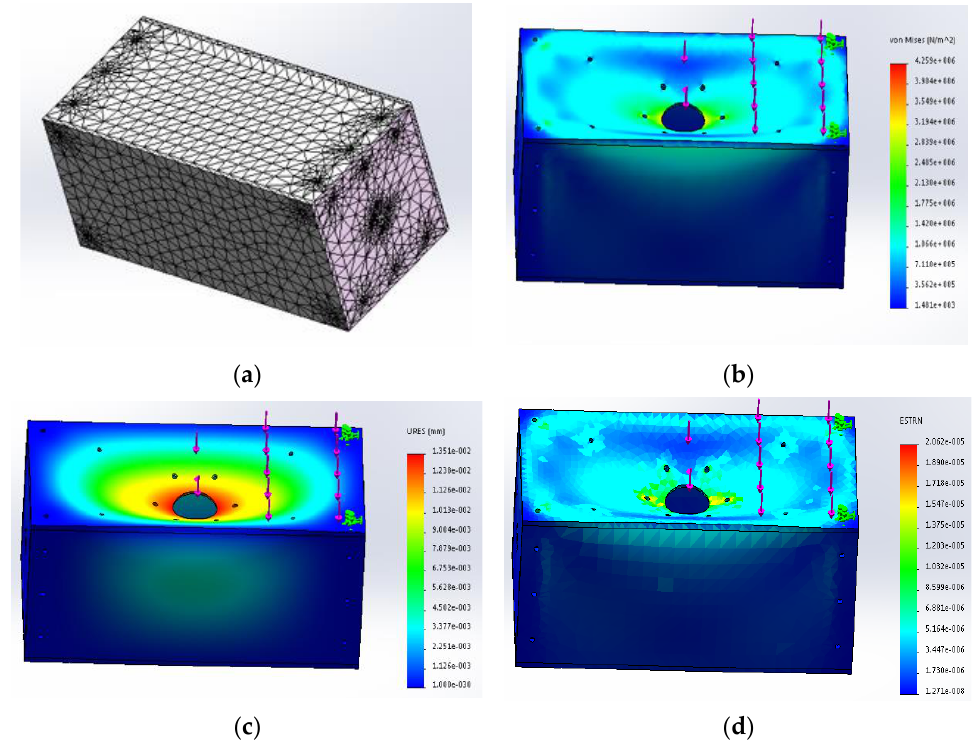
Figure 3. ( a ) Bottom structure meshing. ( b ) Equivalent stress cloud diagram of bottom structure. ( c ) Equivalent displacement cloud map of bottom structure. ( d ) Equivalent strain cloud diagram of bottom structure.